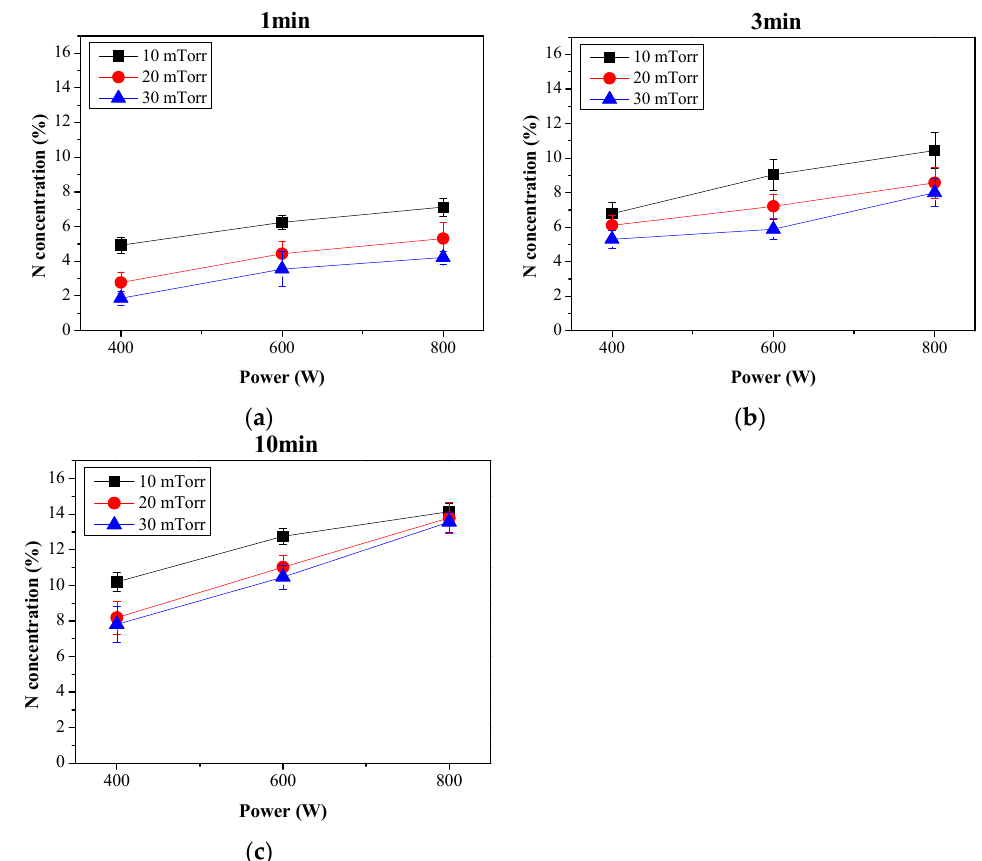
Figure 6. N concentration in the SiON film at ( a ) 1 min, ( b ) 3 min, and ( c ) 10 min. Figure 7 plots the nitrogen concentrations in the thin film as a function of process time and pressure. The nitrogen concentration was expected to increase as the source power and process time increased; however, it eventually converged to a constant value. The nitrogen concentration convergence on the source power increase exhibited different characteristics depending on the pressure. This is consistent with the results obtained by Shahid Rauf [12], which indicated that the surface nitrogen concentration increased linearly with time and tended to saturate after a certain period. In Rauf’s study [12], a 1.3 nm thick SiO 2 thin film showed a tendency to become saturated after 30 s. However, in this study, a 10 nm thick SiO 2 thin film showed a tendency to become saturated after 10 min.